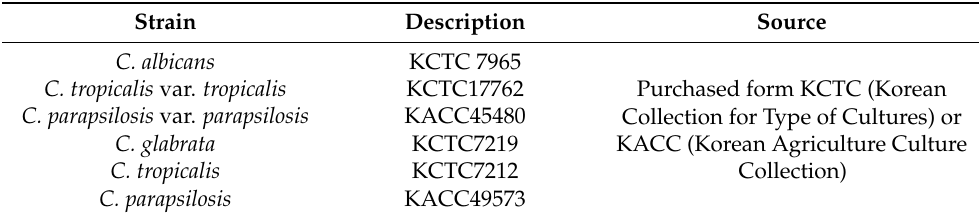
Table 2. Strains used in this